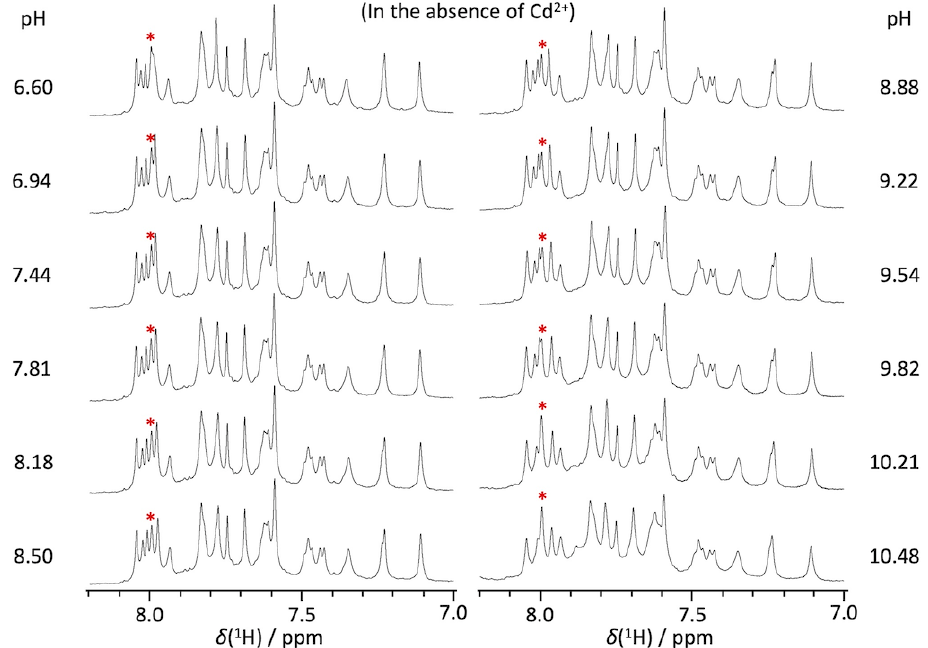
Figure 2. One-dimensional 1 H NMR spectra of the model RNA duplex 1 against various pH levels (basic region) in the absence of CdCl 2 . The H8(G12*) resonance is labeled with a red asterisk in each spectrum. Although chemical shift perturbations for several resonances were observed, these resonances were assigned to terminal residues. To assure the trace of the NMR signals of base protons, 1 H- 1 H NOESY and natural abundance 1 H- 13 C HSQC spectra were recorded at pH 8.18 (Figures S2 and S3).